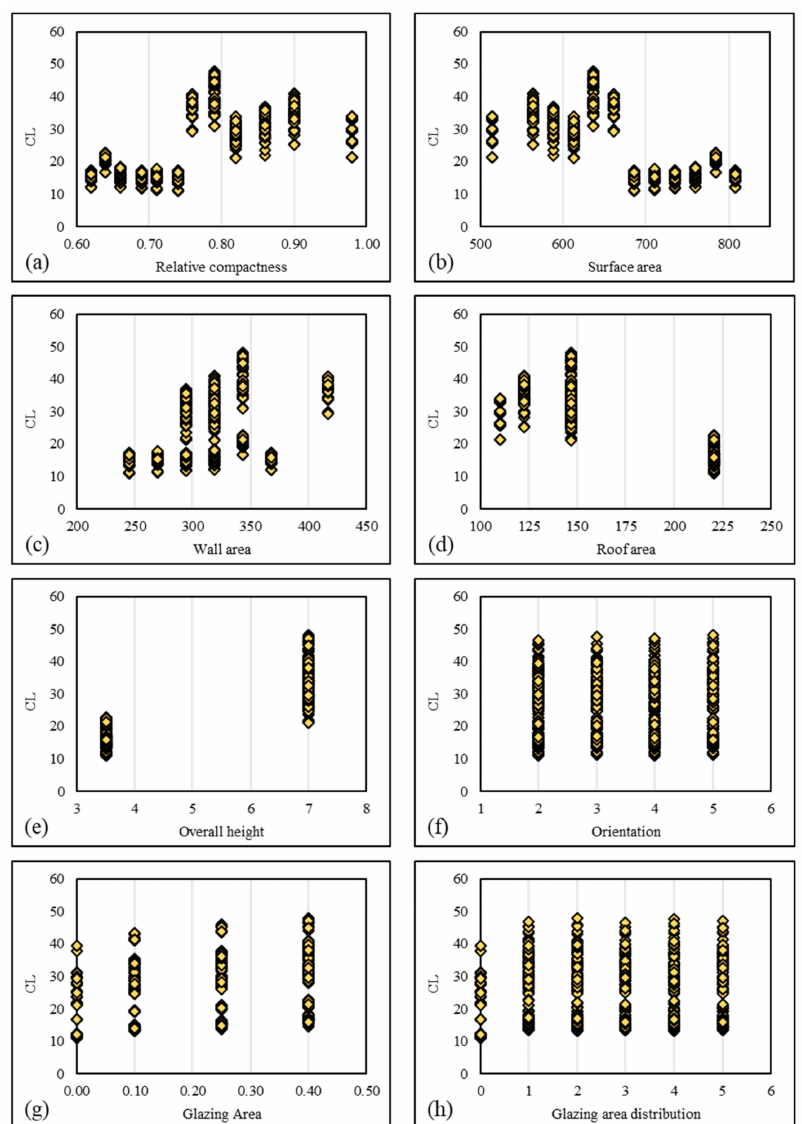
Figure 3. The obtained cooling load (CL) values vs. influential